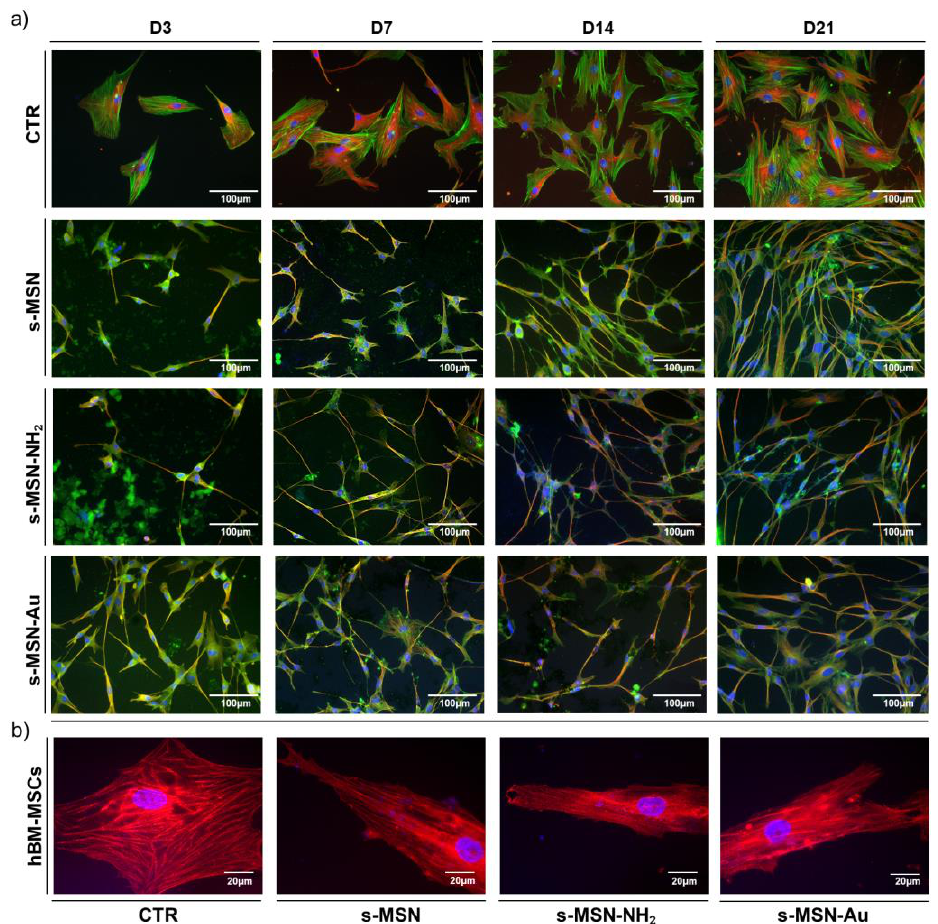
Figure 6. Morphology of hBM-MSCs on s-MSN, s-MSN-NH 2 , and s-MSN-Au during the time in culture. ( a ) Representative images of F-Actin (Phalloidin-Alexa-fluor-488), microtubules (anti- β Tubulin antibody, RED), and nuclei (DAPI, blue) on NPs and control system (CTR). Scale bar = 100 µ m. ( b ) Representative images of expression of Filamin A (anti-Filamin antibody, RED) and nuclei (DAPI, blue) in stem cells on CTR and s-MSN, s-MSN-NH 2 , and s-MSN-Au. Scale bar = 20 µ